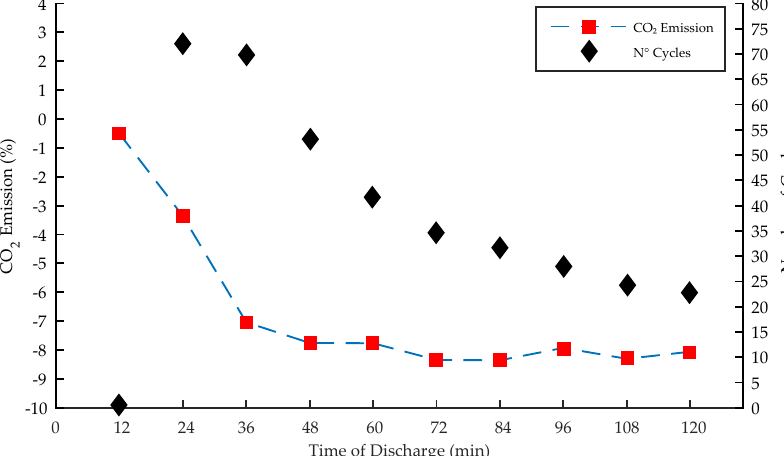
Figure 10. CO 2 emissions reduction in the case of four diesel generators with batteries in comparison to the base case (four diesel generators and no battery). Battery rated power is fixed at 1000 kW. Multiple cases are simulated for different energy capacities, varying the time that the storage would last if we discharge it at the rated power. Every 12 min of discharge time is equivalent to 200 kWh of battery